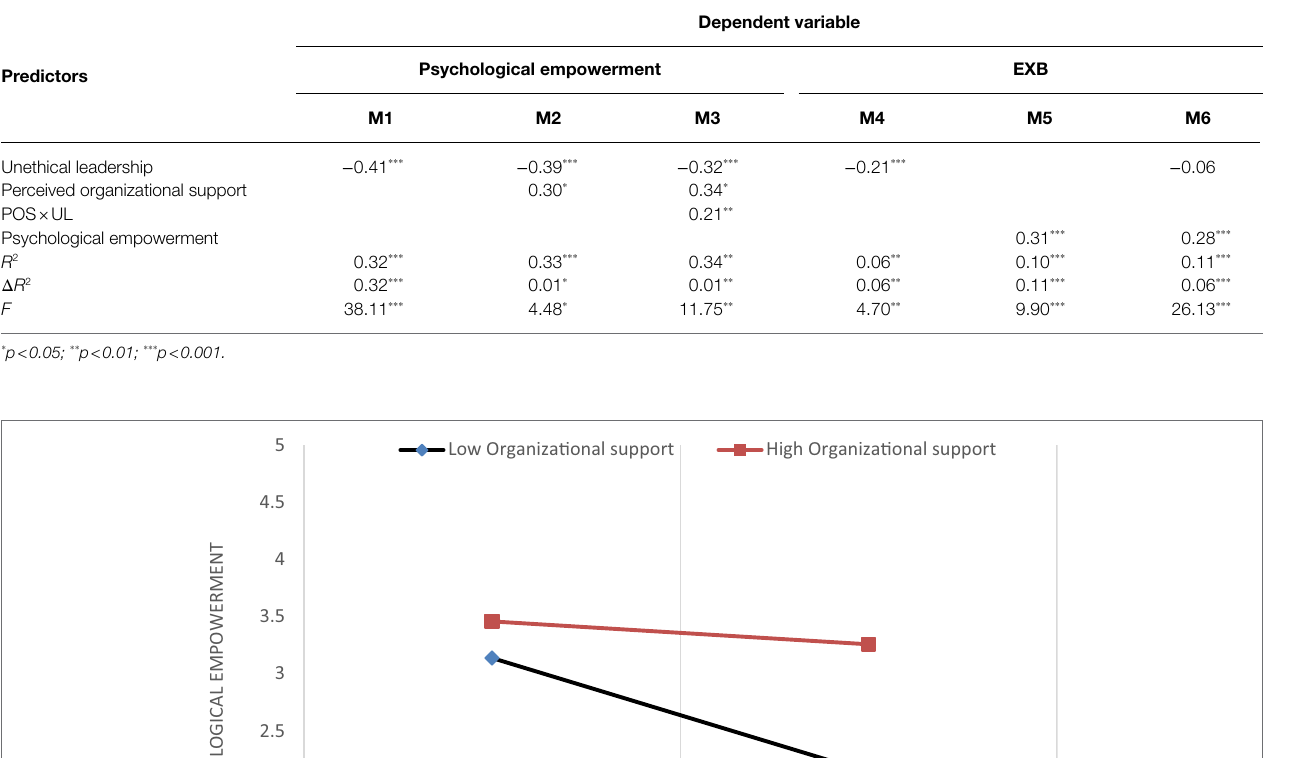
TABLE 4 | Mediating role of PYE and moderating role of